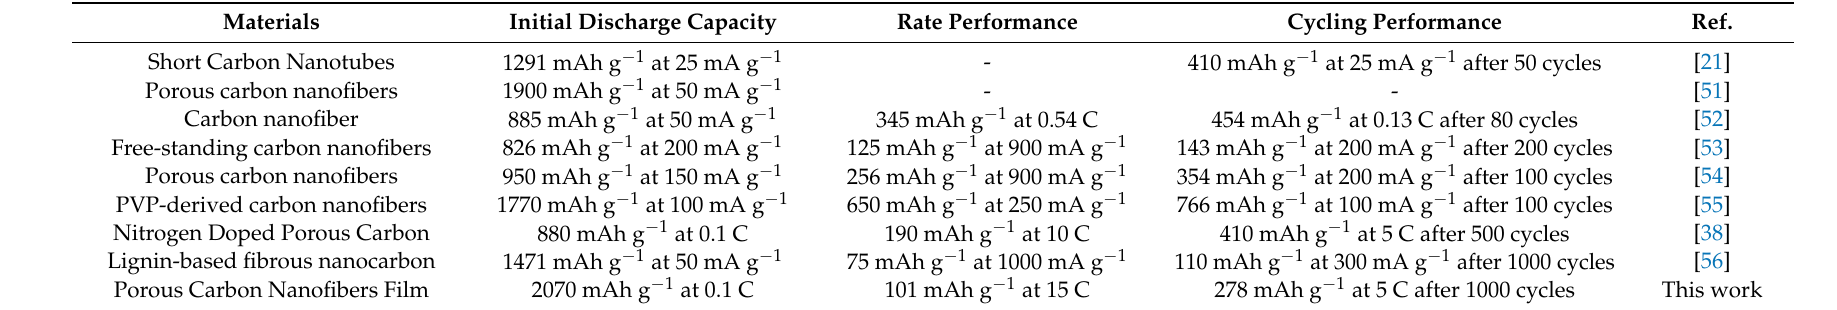
Table 1. The comparison of electrochemical performance of various carbon